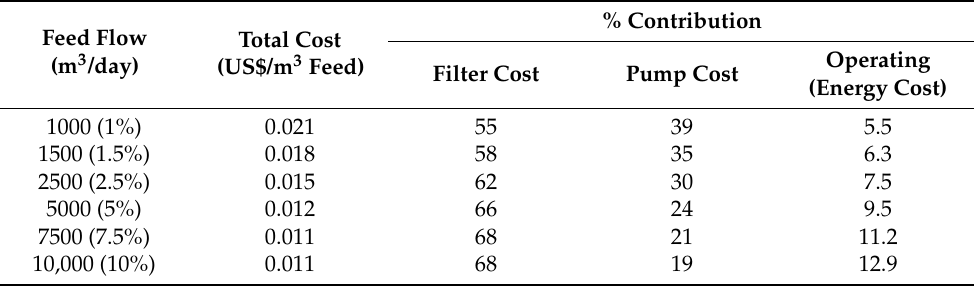
Table 5. The cost of water production of the ceramic filtration process for BW treatment at different feed rates.